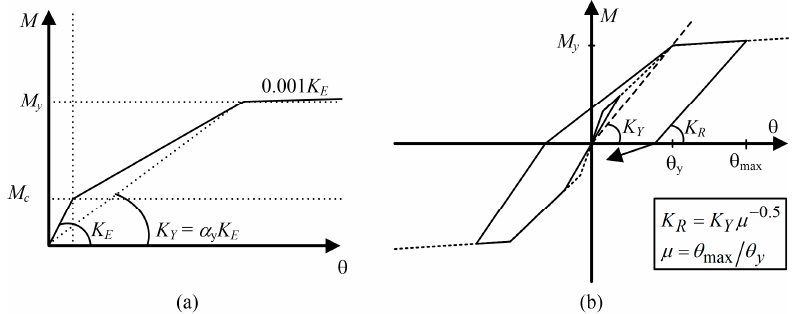
Figure 10. Force-deformation relationship of nonlinear flexural spring: ( a ) envelope and ( b ) hysteresis rule. The envelopes are assumed to be symmetric in the positive and negative loading